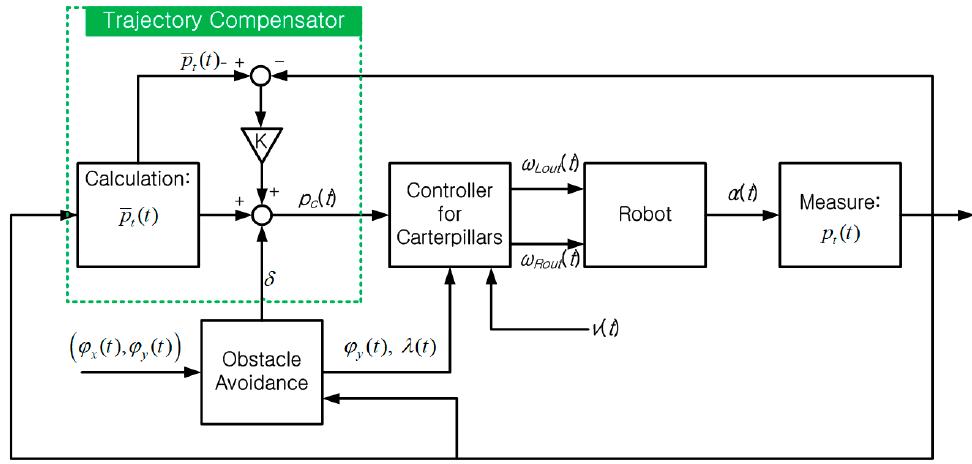
Figure 10. Block diagram of the robot motion control algorithm to reach human survivors.